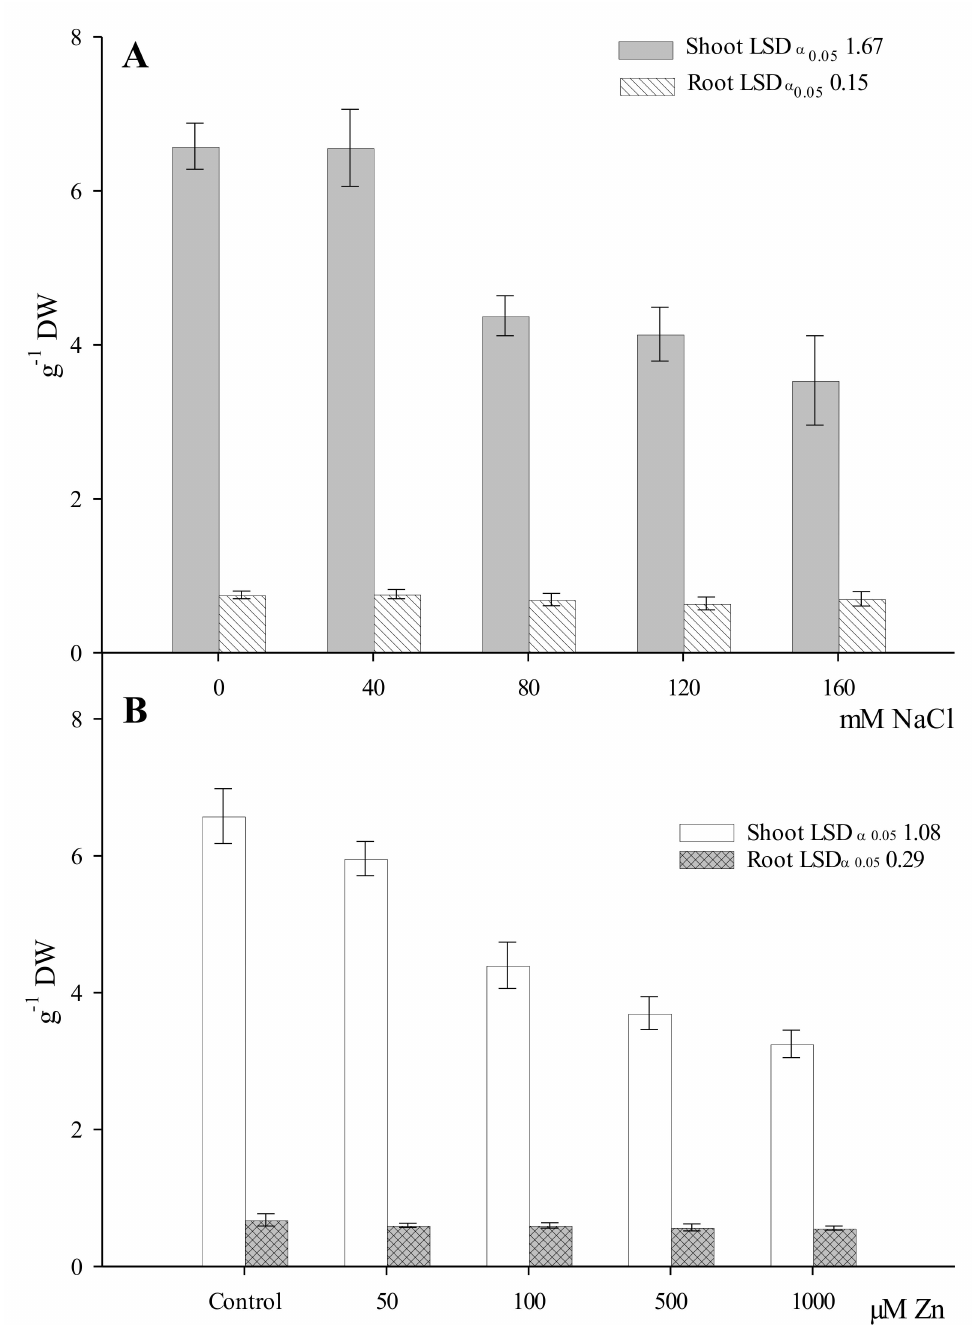
Figure 1. Biomass of pak choi plants. ( A ) Subject under di ff erent salinity conditions. ( B ) Subject under distinct Zn concentrations applied. Values are means ± SE ( n =